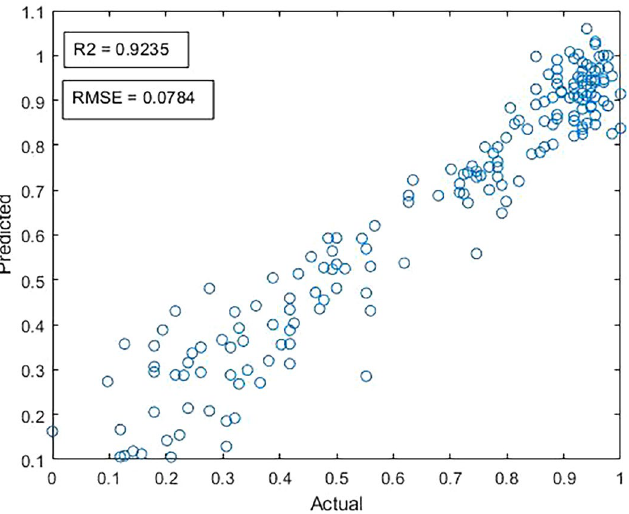
Figure 3. The R 2 and RMSE (ton) of the scatter plot on the MLR model between the actual and predicted crop yield.